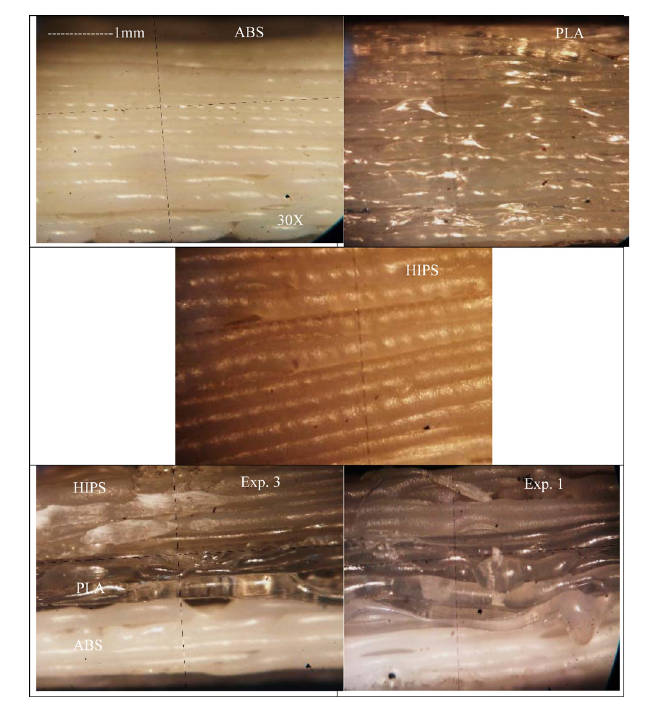
Figure 16. Micrographs of ABS, PLA, HIPS and multi- material